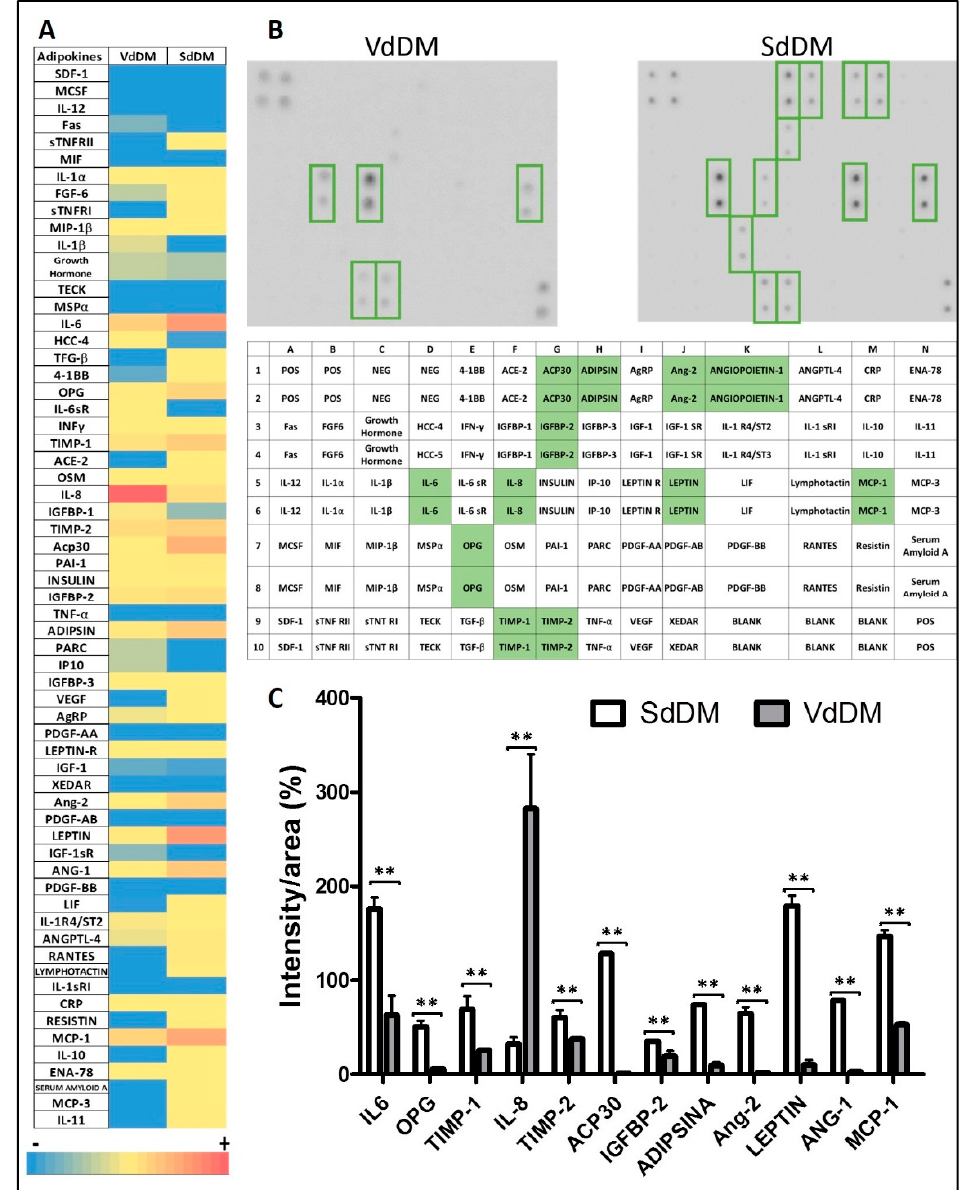
Figure 8. Expression of adipokines present in the secretomes (VdDM or SdDM). Panel A. Color-code heat maps of the density for each array, ranging from zero (blue) to maximum value (red), depicting the different adipokines in rows and the secretomes in columns. Panel B. Upper: array of the VdDM secretome; down: array of the SdDM secretome. Highly expressed adipokines are highlighted. Panel C. Semi-quantitative analysis using ImageJ of adipokines present in the secretomes. Each adipokine was normalized to the levels of POS control signals (which was set at 100% of intensity). Relative values of intensity for each adipokine are shown. Bars indicate mean ± SD of percentage intensity/area from the duplicate spots. Significant differences are represented as: ** adipokine comparisons between secretomes p < 0.01.